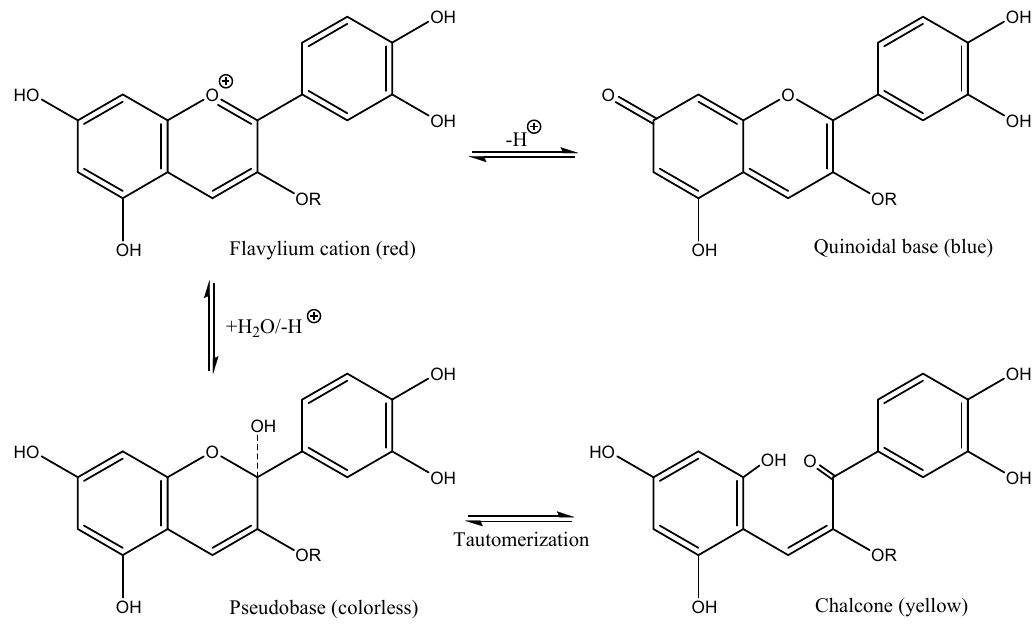
Figure 1. The chemical structures of some anthocyanins based on pH.